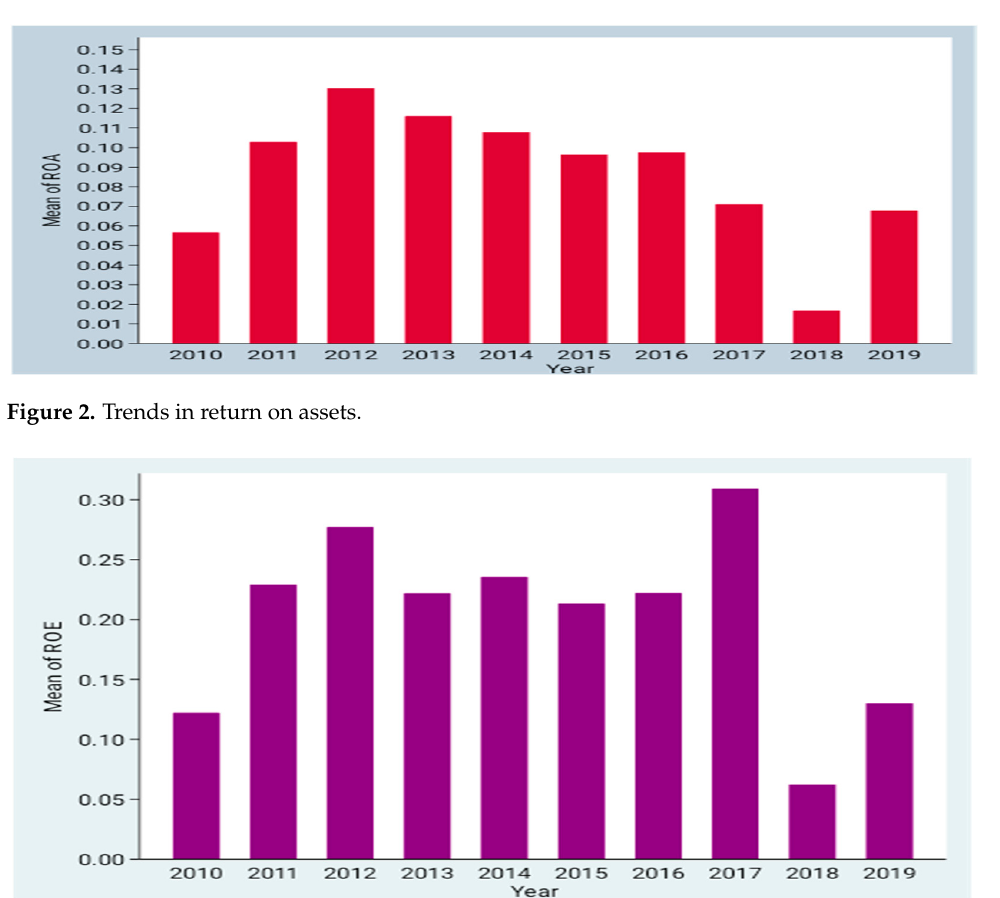
Figure 4. Trends in leverage.